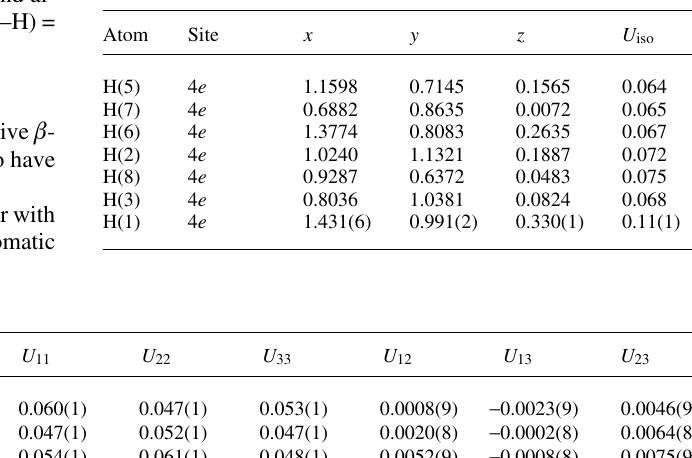
Table 2. Atomic coordinates and displacement parameters (in Å 2 ) .